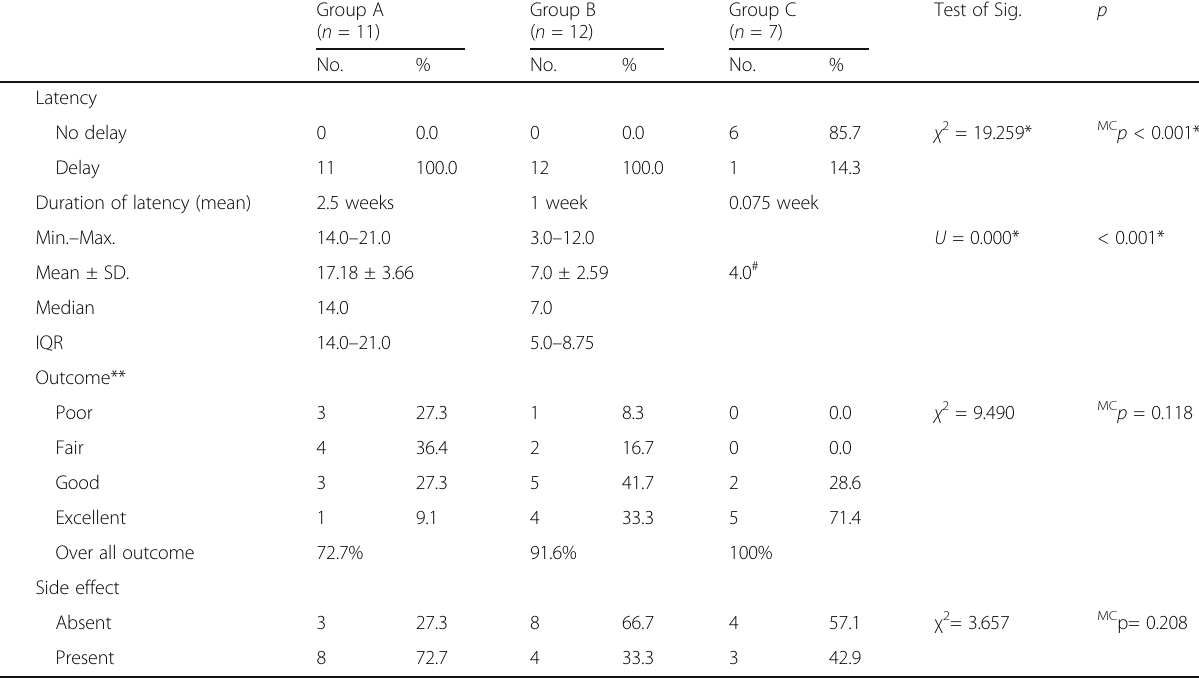
Table 2 Comparison between the three studied groups according to latency of effect, outcome, and side effect Group A ( n =